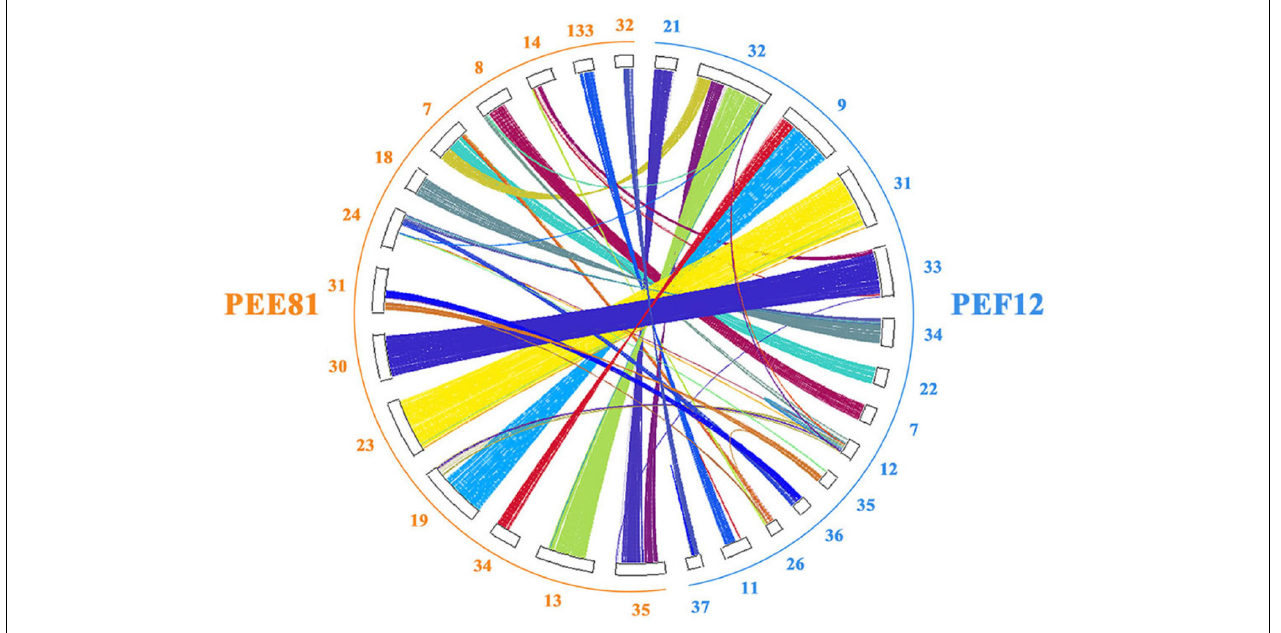
FIGURE 2 | The genome colinearity analysis of the PEE81 and PEF12 using the protein-coding genes.